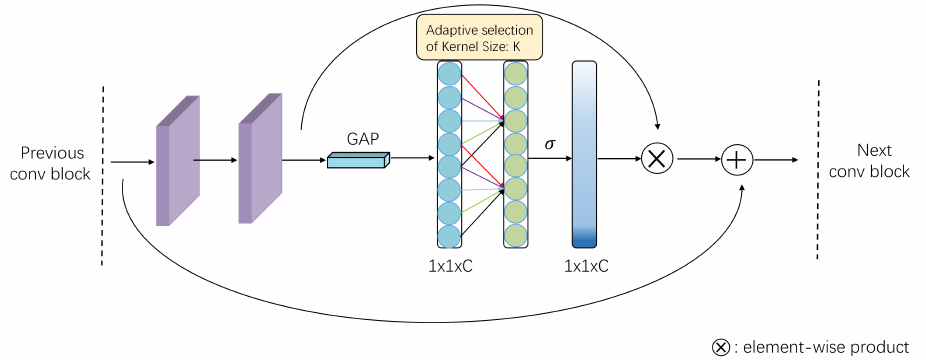
Figure 7. The Residual propagation with Efficient Channel Attention